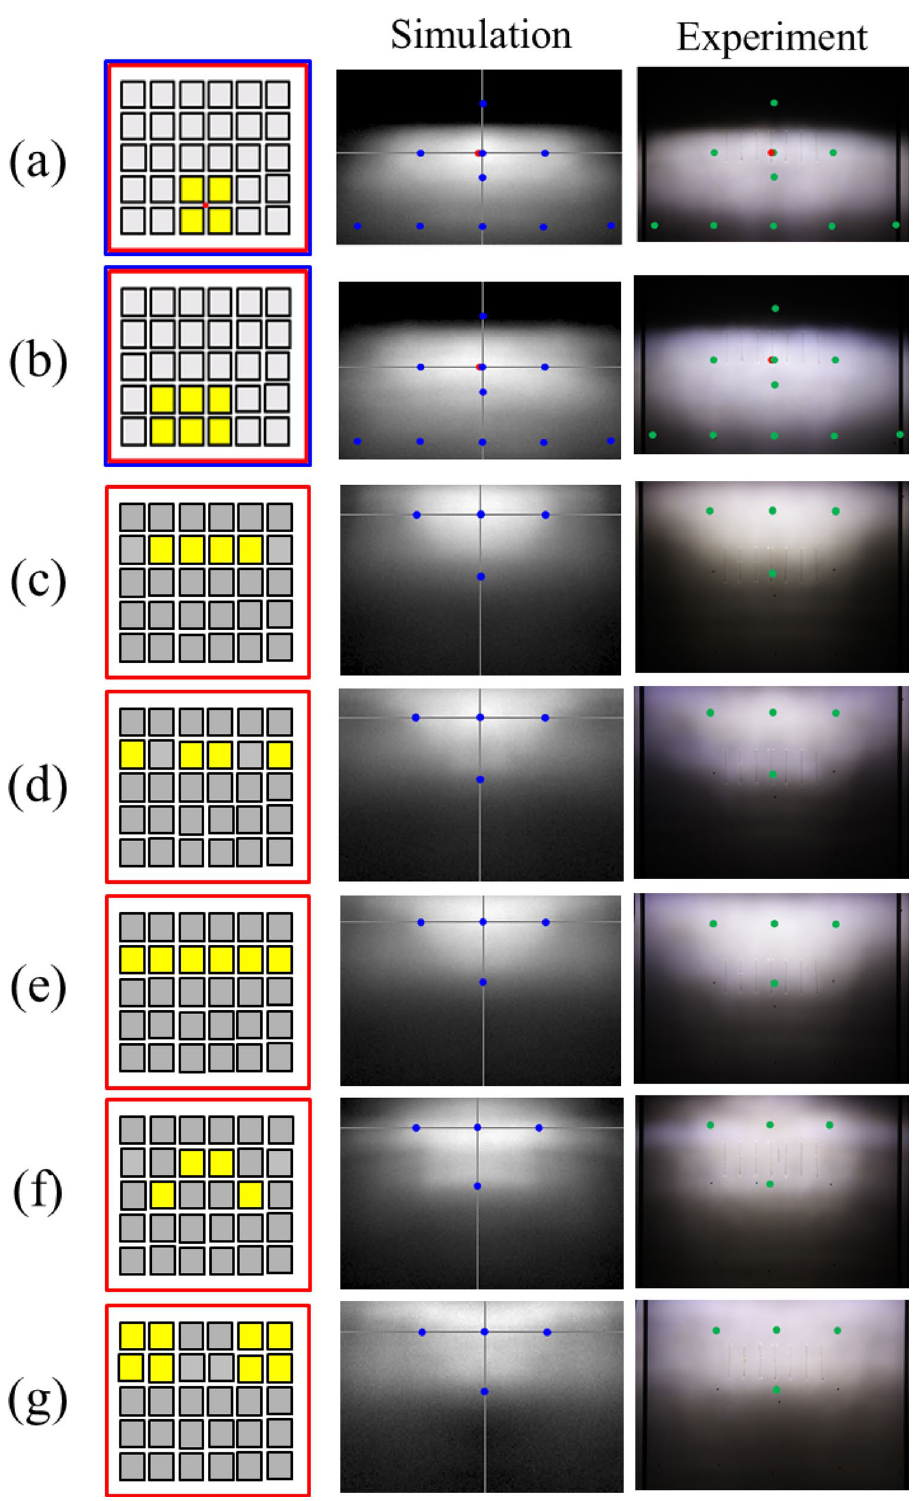
Figure 8. The simulated and observed light patterns and the corresponding turn-on LED dies for ( a , b ) low beam, and ( c – g ) high